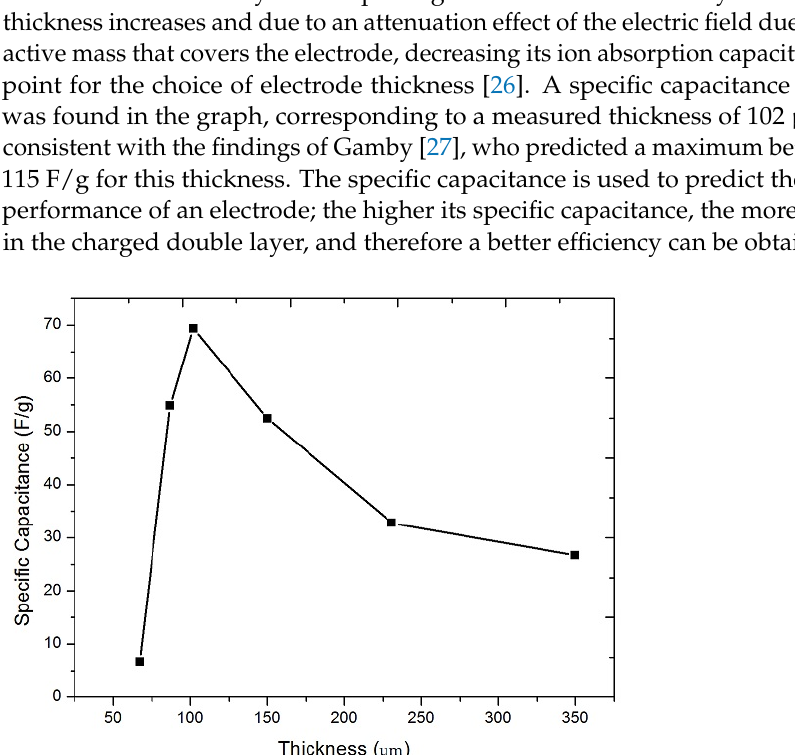
Figure 5. Specific capacitance for different thicknesses of activated carbon electrodes applied onto a graphite electrode.